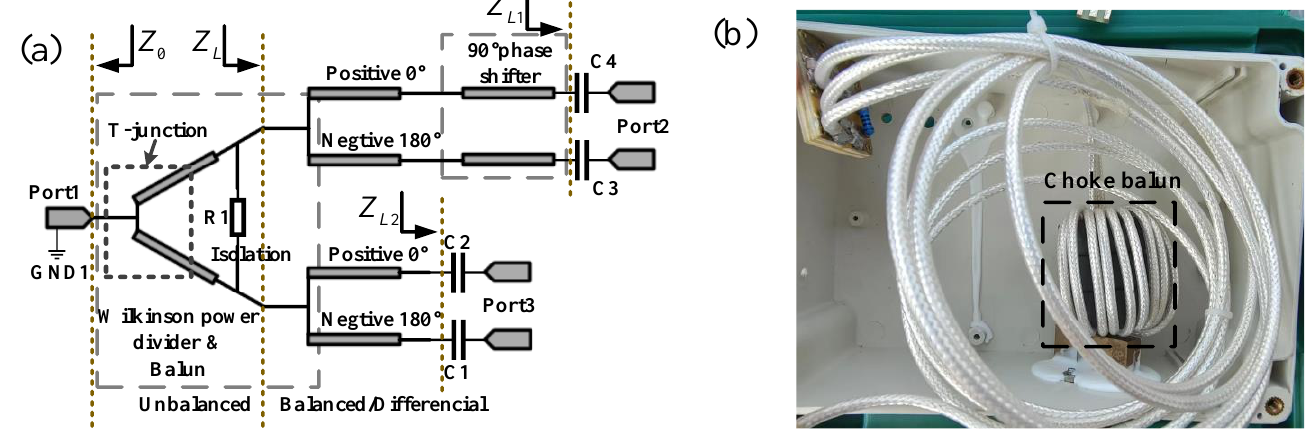
Figure 6. ( a ) The schematic diagram of the designed feeding network of the proposed antenna. ( b ) The designed flux coupled balun.